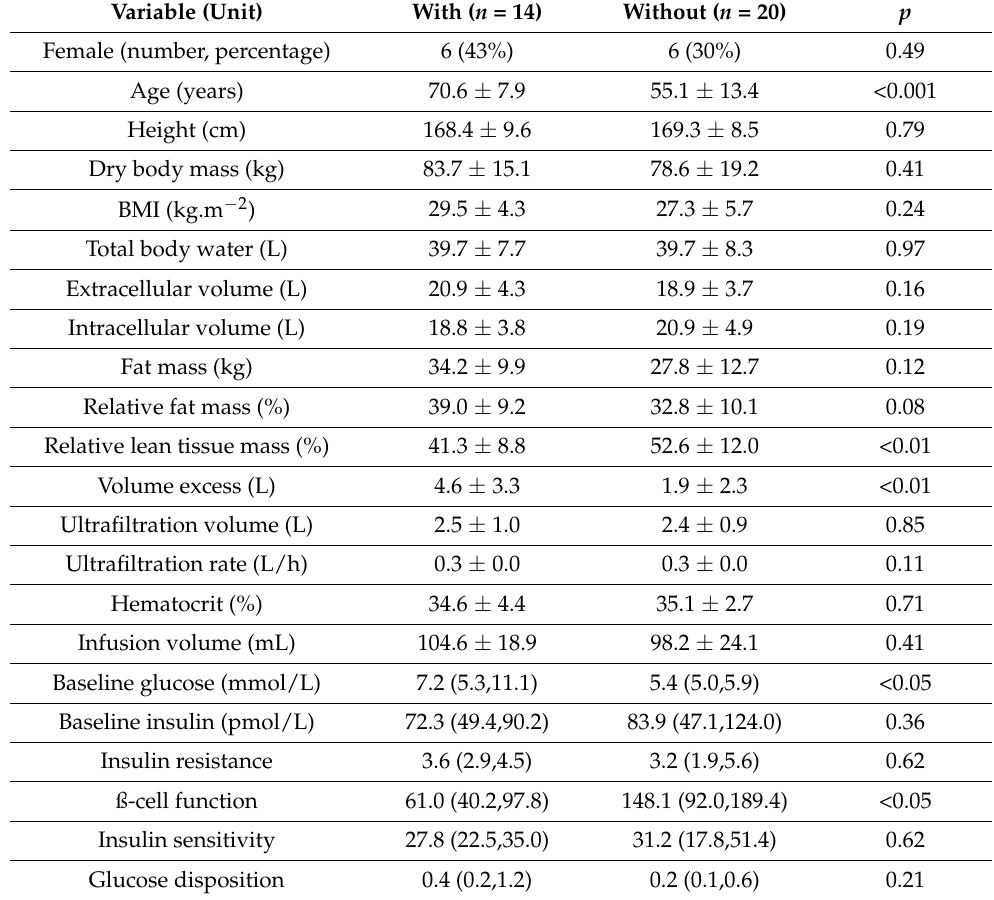
Table 1. Anthropometric and treatment data in subjects with and without T2D. Variable (Unit) With ( n =